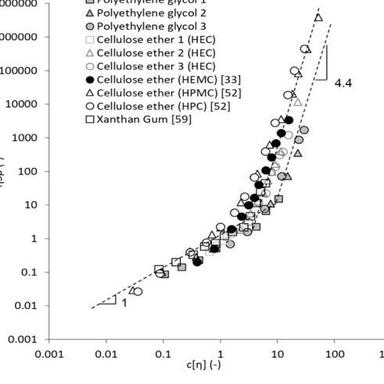
Specific viscosity as a function of (a) polymer dosage (b) c. Adapted from.